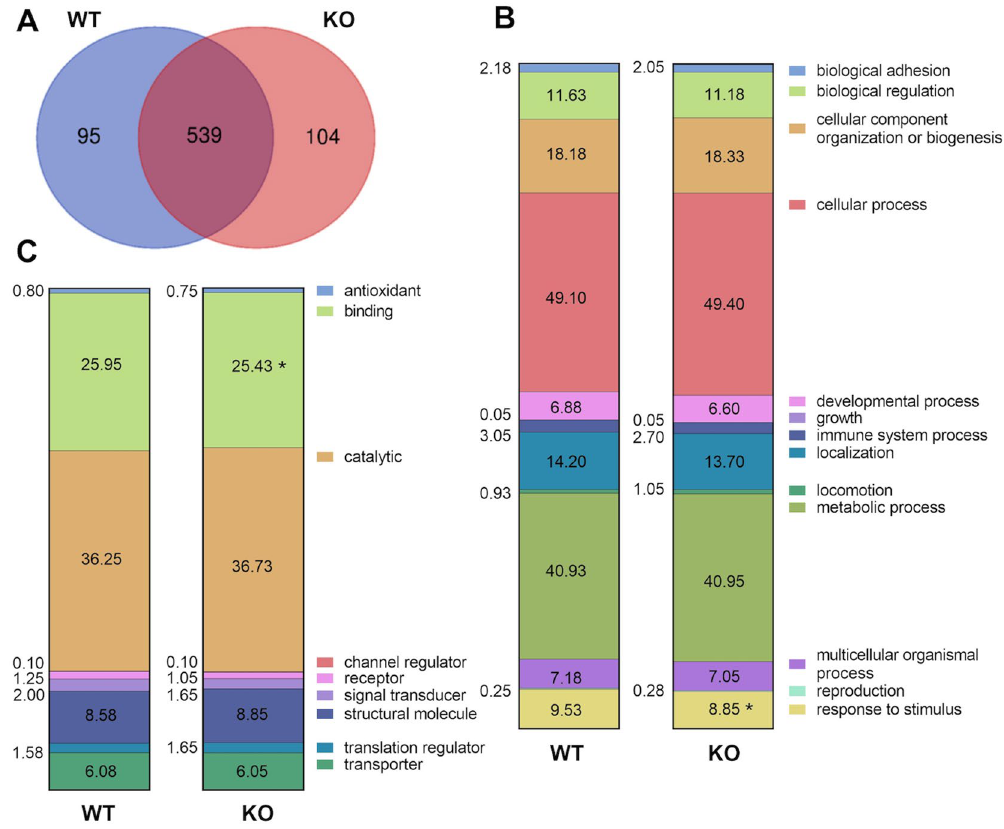
Figure 1. LC/MS–MS analysis in decellularized subcutaneous adipose tissue from WT and KO mice. ( A ) Venn diagram summary showing protein variability between WT and KO (only included proteins that were expressed in all replicates). Comparison between ( B ) biological processes, and ( C ) molecular functions signaling pathways showed that WT and KO ECM had differences in the “binding” and “response to stimulus” signaling pathways. Proteins were quantified using the exponentially modified protein abundance index (emPAI), which relates the number of unique peptides observed for a specific protein to the number of observable peptides in the sample. n = 3 biological samples with 3 technical replicates. The significance threshold was set at p < 0.05, with a False Discovery Rate of 5% using